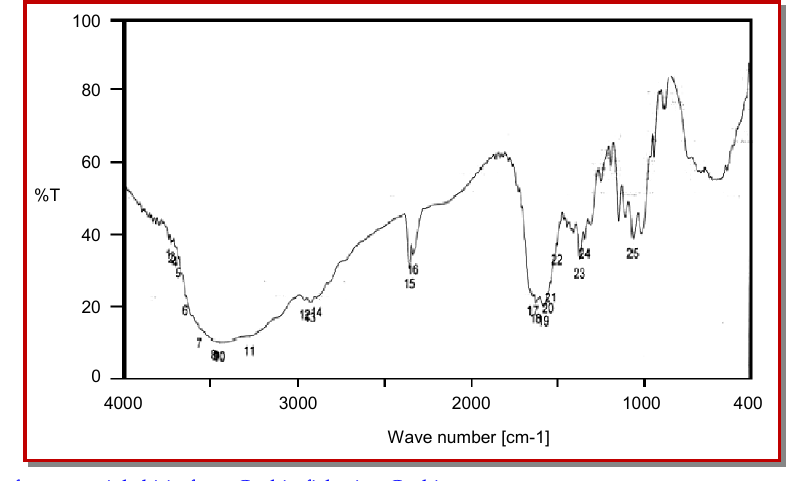
Figure 1: IR Spectra of commercial chitin from Cochin fisheries, Cochin